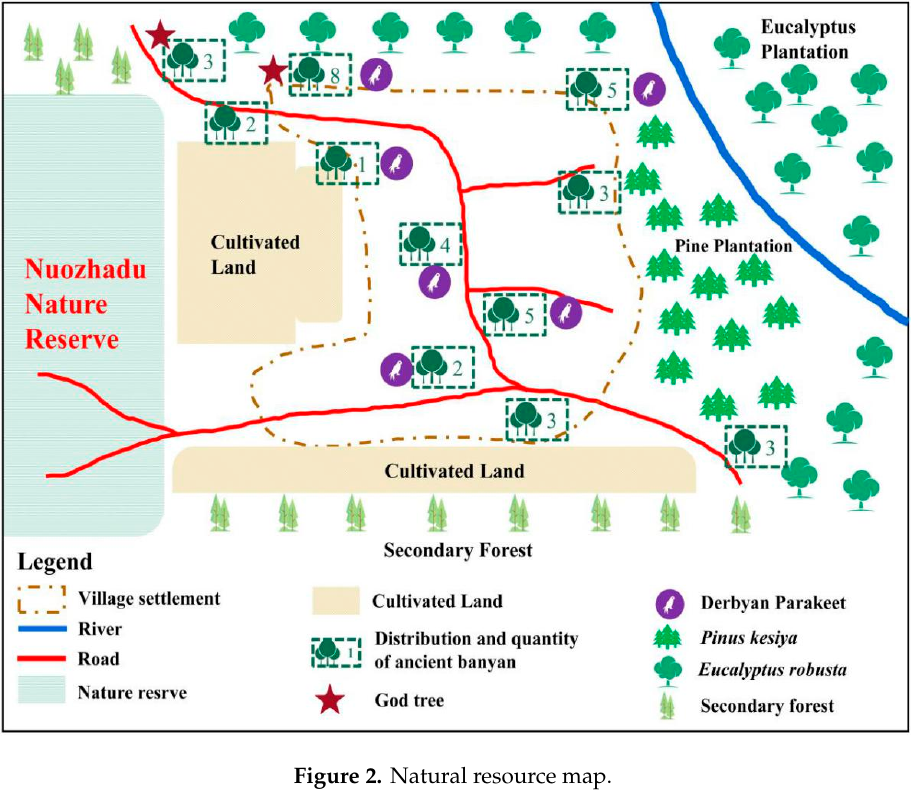
Figure 2. Natural resource map.